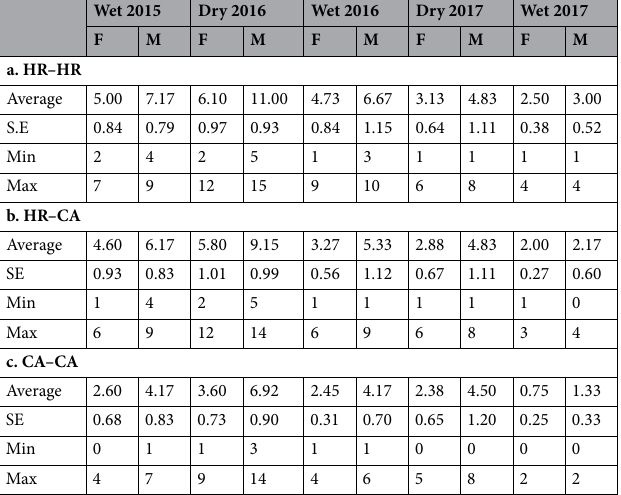
Table 2. Seasonal estimates of degree (number of animals an individual overlapped with in space use) for female (F) and male (M) wild pigs at Buck Island Ranch, Florida. We estimated degree among home ranges (HR–HR), between home ranges and the individual’s core area (HR–CA), and among core areas (CA–CA). Degree information includes standard error (S.E.), minimum values (Min.), and maximum values (Max).